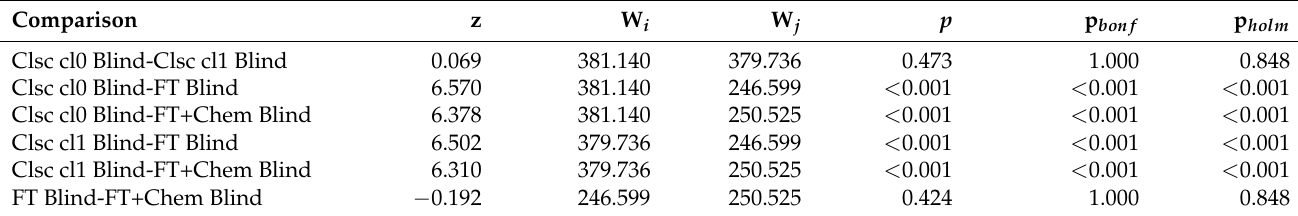
Figure 4. Summary of the benchmarking results with the PDBbind core set. ( A ) Boxplots combined with stripplots illustrate the distribution of the RMSD results for each benchmarking protocol. ( B ) Success rates at a 2.0 Å cutoff. Numbers printed inside the bars indicate success rates expressed in percentage rounded to three significant digits. Light bars (all) represent success rates for the whole datasets, while dark bars (no het.) represent success rates for the datasets with a filter to exclude receptors with nonstandard atoms. Table 4. Dunn post-hoc test for the RMSD distributions between the benchmarking protocols belonging to the blind docking group in the PDBbind benchmarking